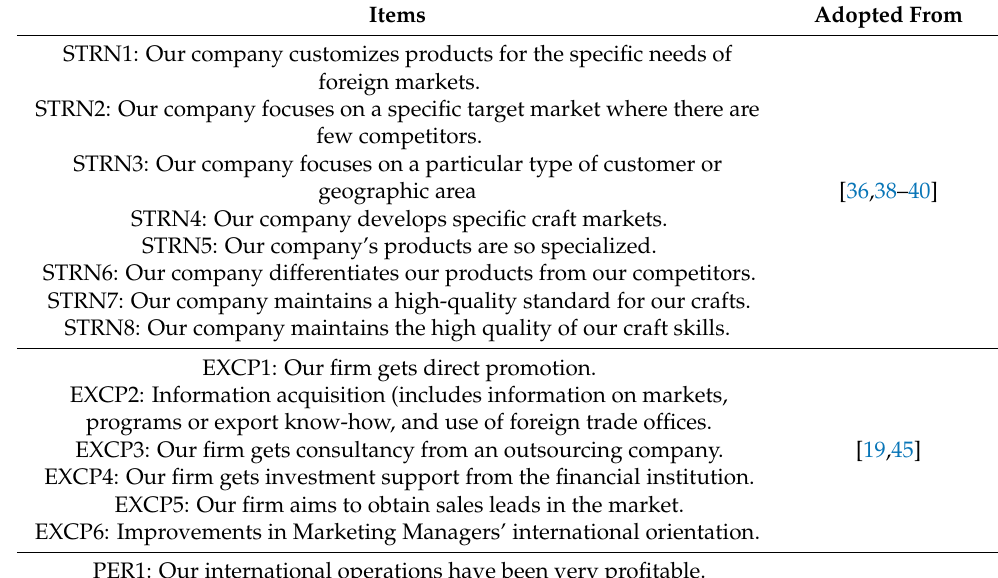
Table 1. The items used in the questionnaires. Items Adopted